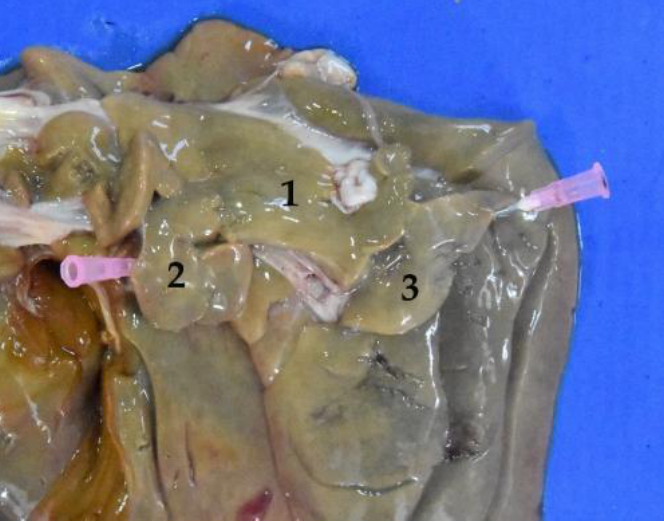
Figure 26. Visceral face of the liver. ( 1 ) Caudate lobe; ( 2 ) papillary process; ( 3 ) caudate process.